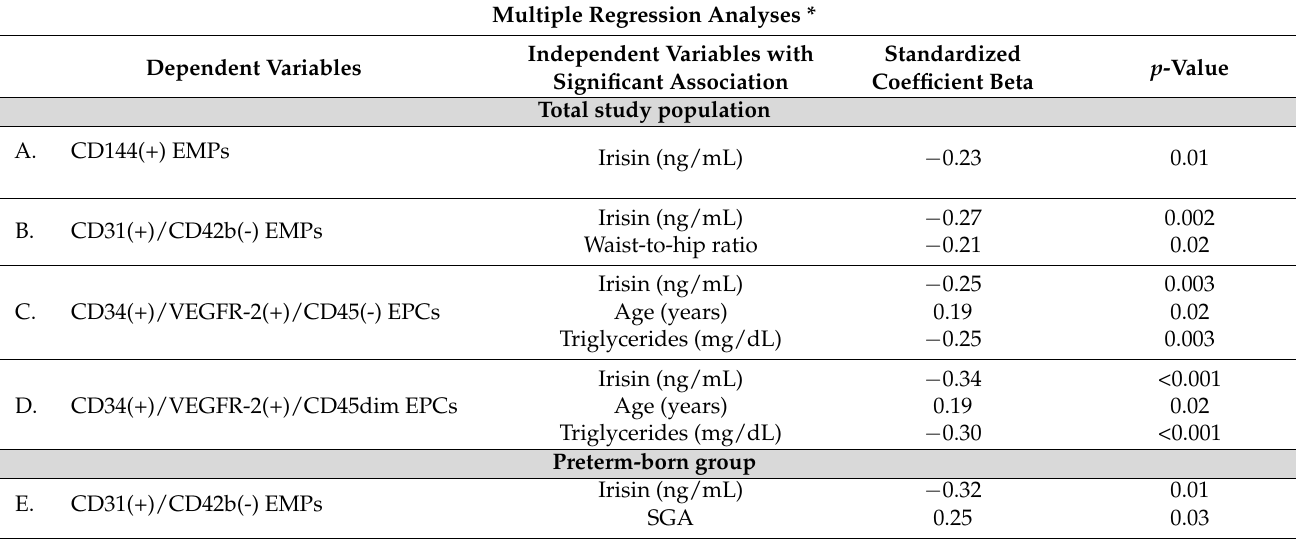
Table 2. Multiple regression analyses for independent associations of endothelial microparticles (EMPs) and endothelial progenitor cells (EPCs) with irisin levels, anthropometric and metabolic parameters in the total study population and in the preterm-born